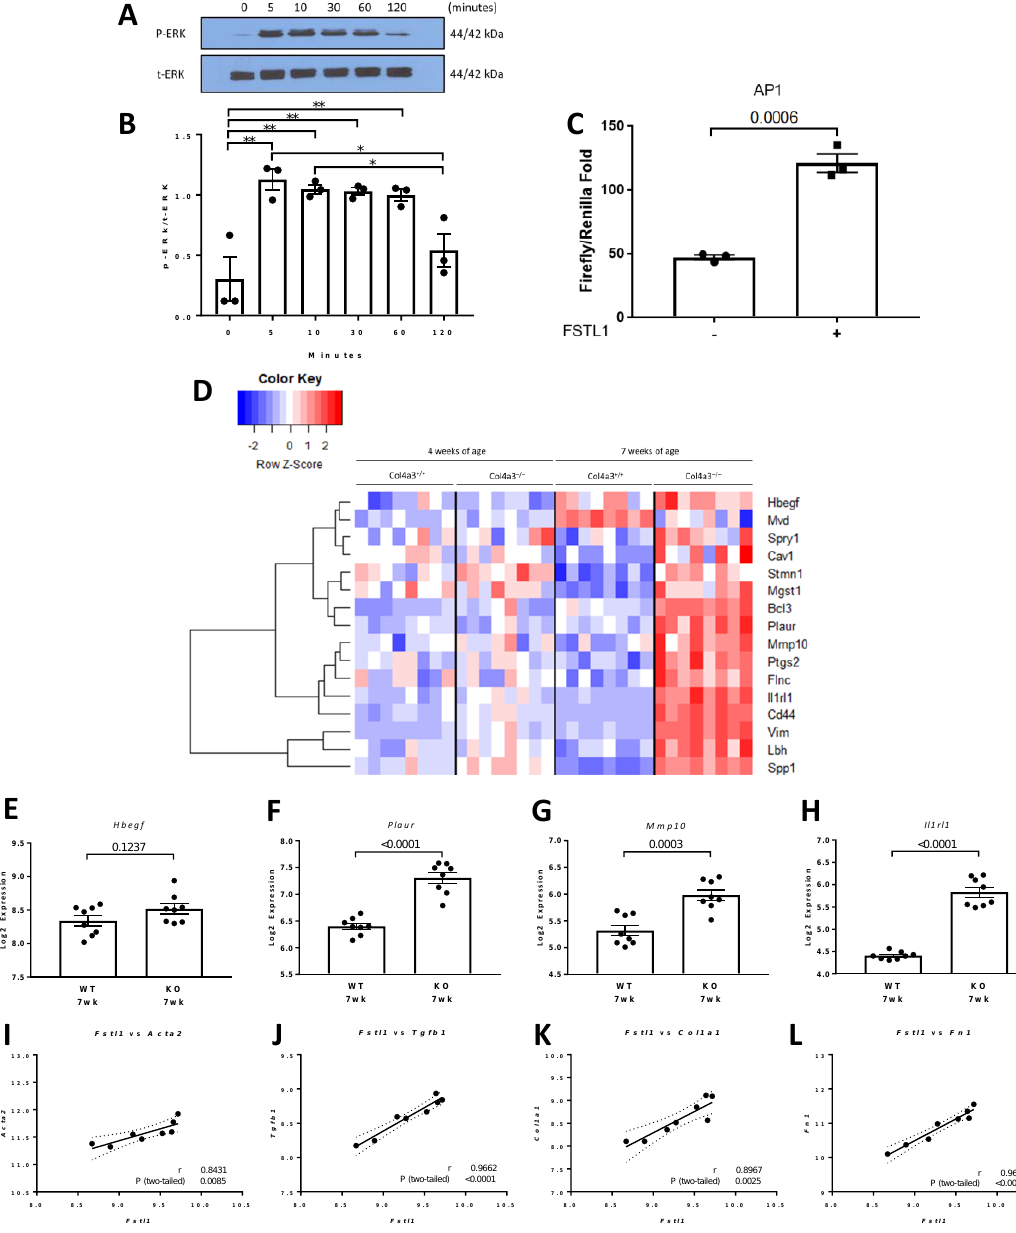
Figure 10. p42/p44 MAPK (ERK) activation and AP1-related gene expression. ( A ) Representative immunoblots for phosphorylated (P-ERK) and total (t-ERK) extracellular signal-regulated kinase in immortalized human proximal tubule epithelial cells that were treated with rhFSTL1 for either 0, 5, 10, 30, 60, or 120 min. ( B ) Densitometry intensities were quantified and normalized to total ERK ( n = 3). Values are mean ± SEM. p values were determined by one-way ANOVA. Significance was defined as a p value of < 0.05. ( C ) Immortalized human proximal tubule epithelial cells were transfected with an AP1 luciferase reporter plasmid. The experimental group of cells were incubated in rhFSTL1 for 24 h ( n = 3 per group). Luciferase activity was subsequently determined. Values are the mean ± SEM (black bars). Values are mean ± SEM, and significance was defined as a p value of < 0.05 by Student’s t tests. ( D ) Heat map with unsupervised hierarchical cluster analysis of AP1 related genes in kidneys of 4 and 7 week old Col4a3 –/– and wild-type mice ( n = 8 per group). ( E – H ) Graphical representation of selected mRNA levels in 7 week old wild type versus 7 week old Col4a3 –/– mice. Values are mean ± SEM, and significance was defined as a p value of < 0.05 by Student’s t tests. ( I – L ) Fstl1 mRNA levels were correlated with Acta2 , Tgfb1 , Col1a1 , and Fn1 mRNA levels. Pearson’s correlation coefficient ( r ) was determined, and two-tailed p values derived. Linear regression generated the line of best fit (solid lines) with 95% confidence intervals (dotted lines). Significance was defined as a p value < 0.05. * p value < 0.05. ** p value <